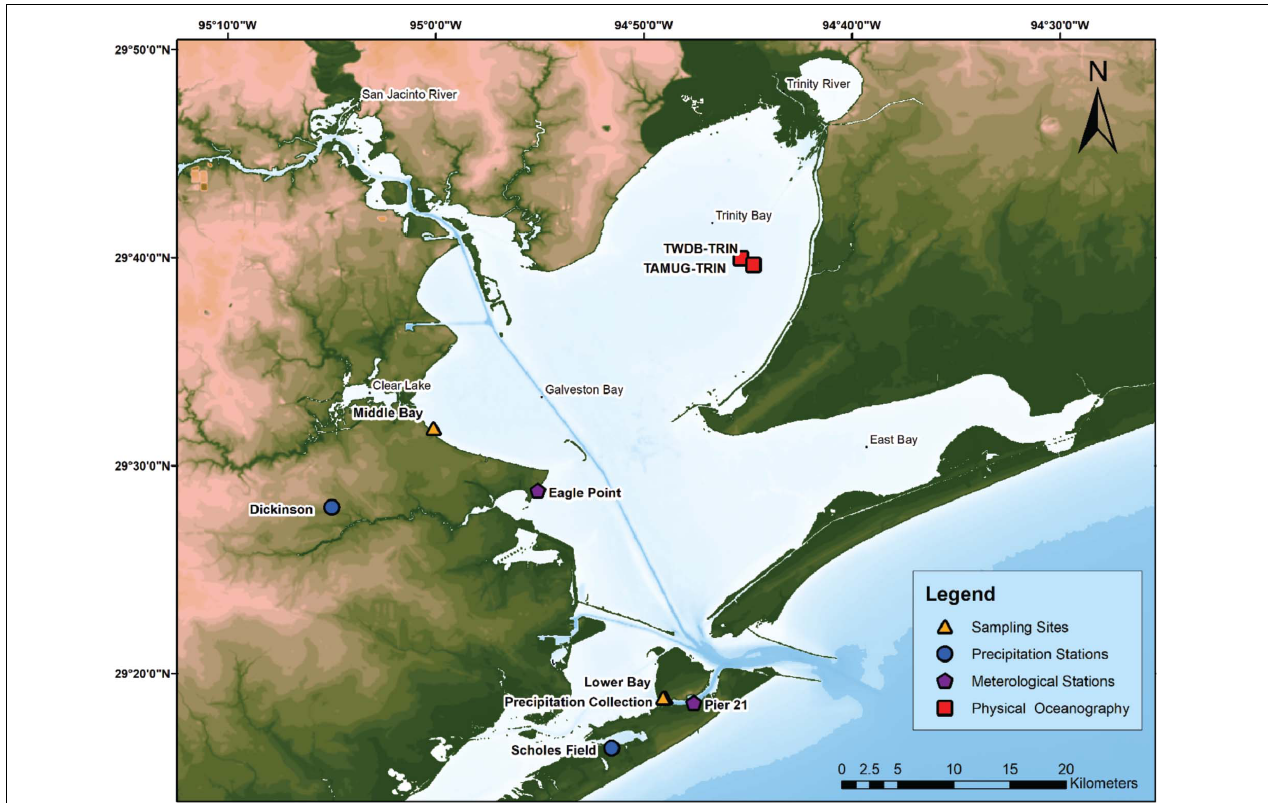
FIGURE 1 | Map of Study Area and Sampling Stations, including Meteorological Stations (pentagon), Precipitation stations (circle), suspended sediment/precipitation sampling sites (triangle), and physical oceanography sites